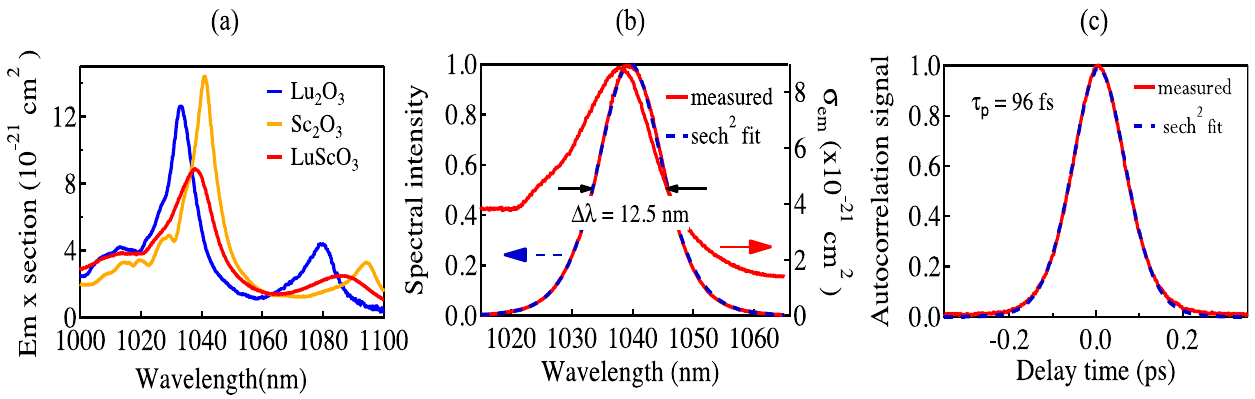
Figure 19. ( a ) Emission spectrum of the mixed cubic sesquioxide Yb:LuScO as a result of the combination of Yb:LuO and Yb:ScO; ( b ) Spectrum of the modelocked laser delivering 96 fs, showing a 12.5 nm-wide (FWHM) modelocked spectrum, together with the emission spectrum of Yb:LuScO. The observed red-shift is due to the low inversion level at which the laser operated, with an output coupling rate of 2.6%; ( c ) Autocorrelation trace of the 96 fs pulses, showing clean sech 2 shaped soliton